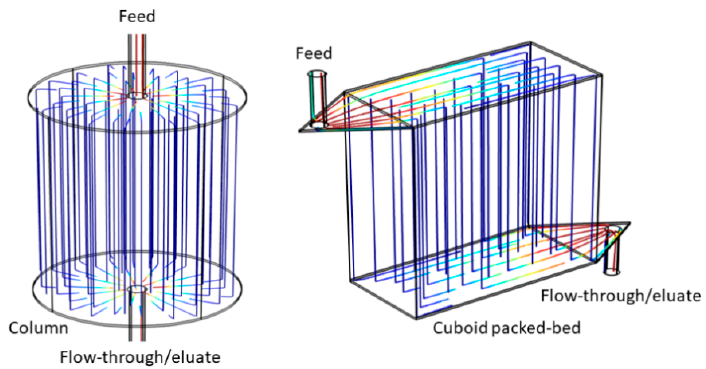
Figure 1. Idealized flow paths within a column and a cuboid packed-bed device.